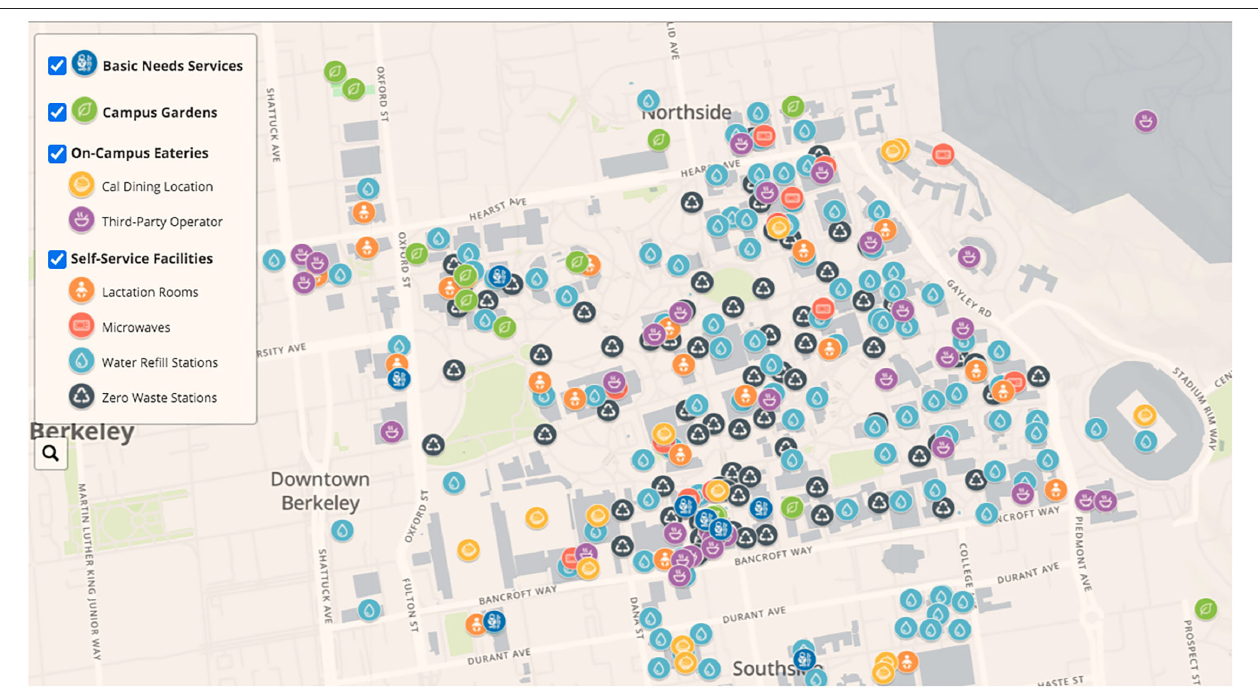
FIGURE 2 | Geographic asset map. In the online map, each icon opens to a pop-up with information about the resource. See: https://food.berkeley.edu/foodscape/ geographic-map/. Basic needs data collection by Emily Altman and Natalia Semeraro. Campus gardens data collection by Nathalie Muñoz, Meg Prier, and Natalia Semeraro. Campus eateries data collection by Will Payne, Melina Packer, Hortencia Rodríguez, and Kevin Tuok. Lactation room data collection by Kim Guess. Microwave data collection by KC Chung, Margaret Shi, Hannah Tong, and Lucy Yu. Water refill station data collection by Kevin Tuok and students of NST 166: Nutrition in the community with Professor Mary Lesser. Zero waste station data collection by Claudio Valencia. Visualization and development by Will Payne and Kevin Tuok. Map icons by Kevin Tuok and Shalandy Zhang. Project manager: Rosalie Zdzienicka